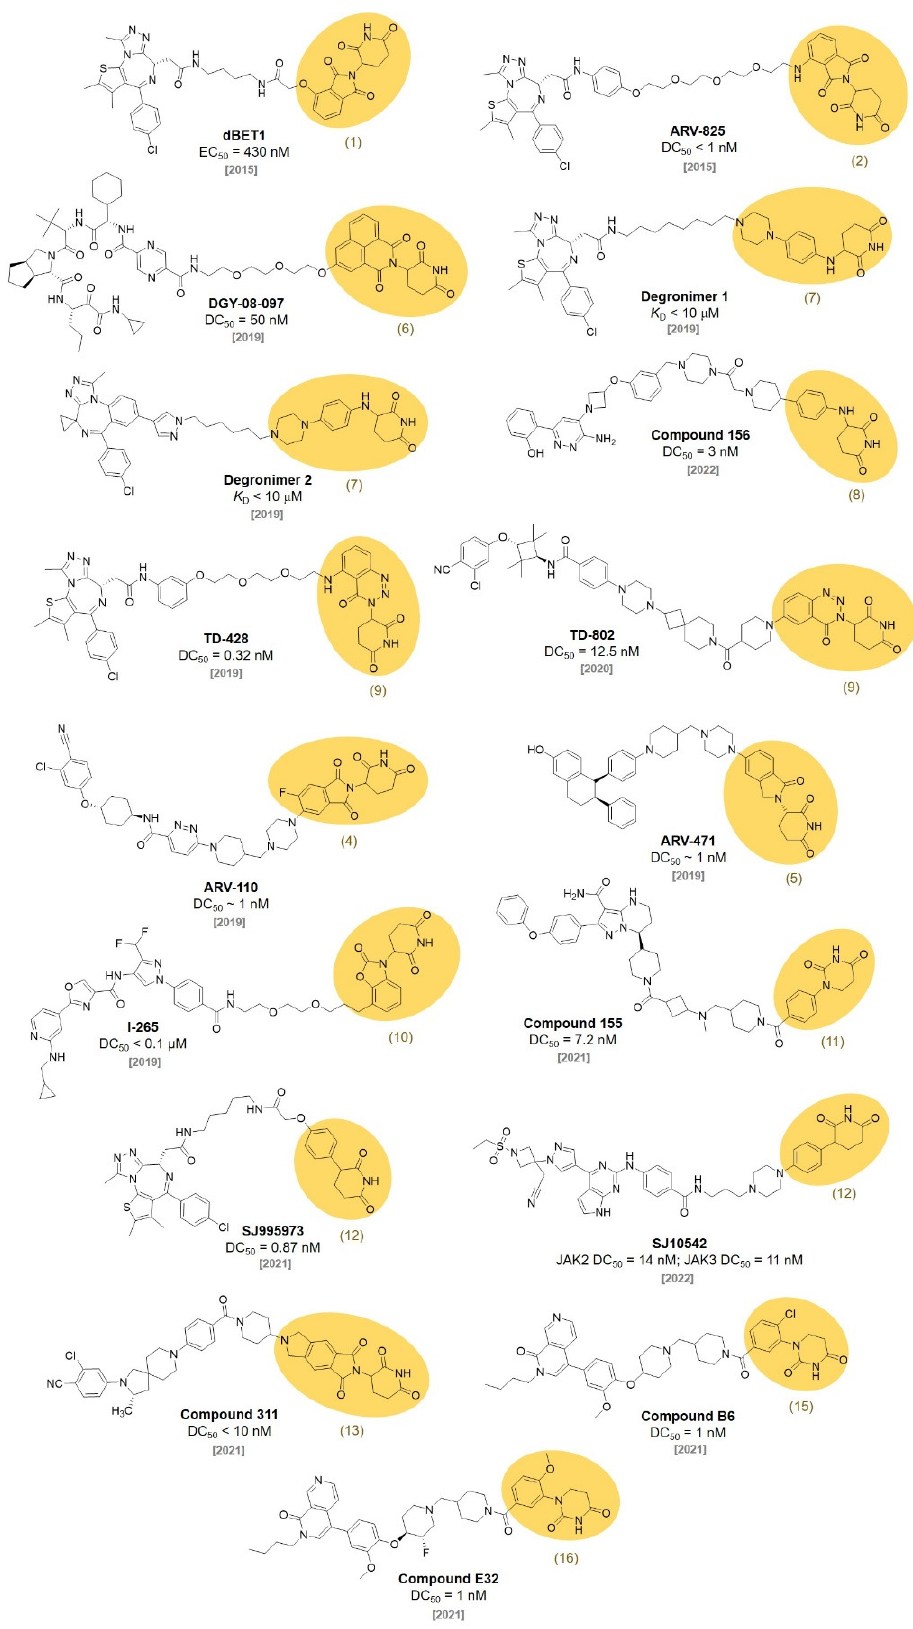
Figure 3. Examples of CRBN ligand-based PROTACs. In 2018, the Crew group reported 22 thalidomide analogs with a rapid one-pot syn- thesis without purification. They measured the binding affinities of newly synthesized thalidomide analogs to CRBN with a surface plasmon resonance analysis. In addition, the ability to induce the degradation of Aiolos and CK1 α was investigated. Among them, three thalidomide analogs ( 4 , 5 , 6 ) showed improved pharmacological properties and good CRBN binding affinities ( K D for 4, 5, and 6 were 55, 549, and 111 nM, respectively).